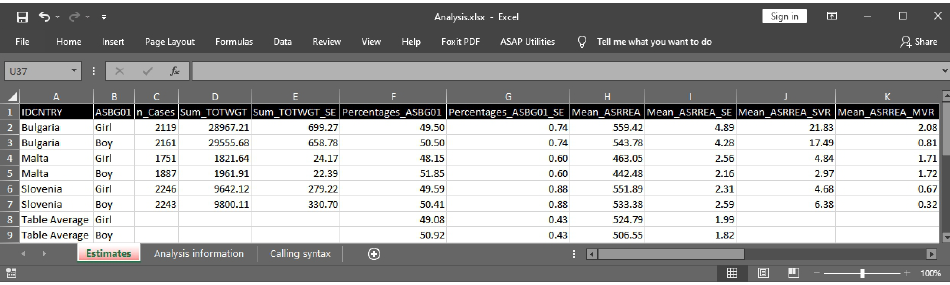
Figure 2. Sample MS Excel